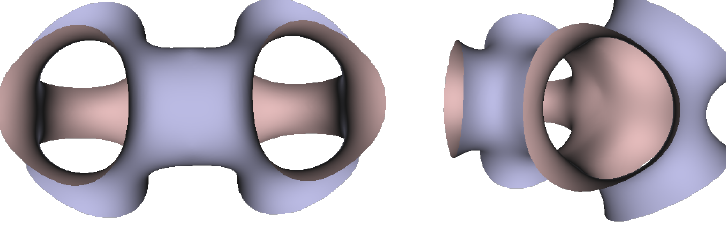
Figure 8. Two views of the TIS P-surface generated from two connecting tetrahedrons.